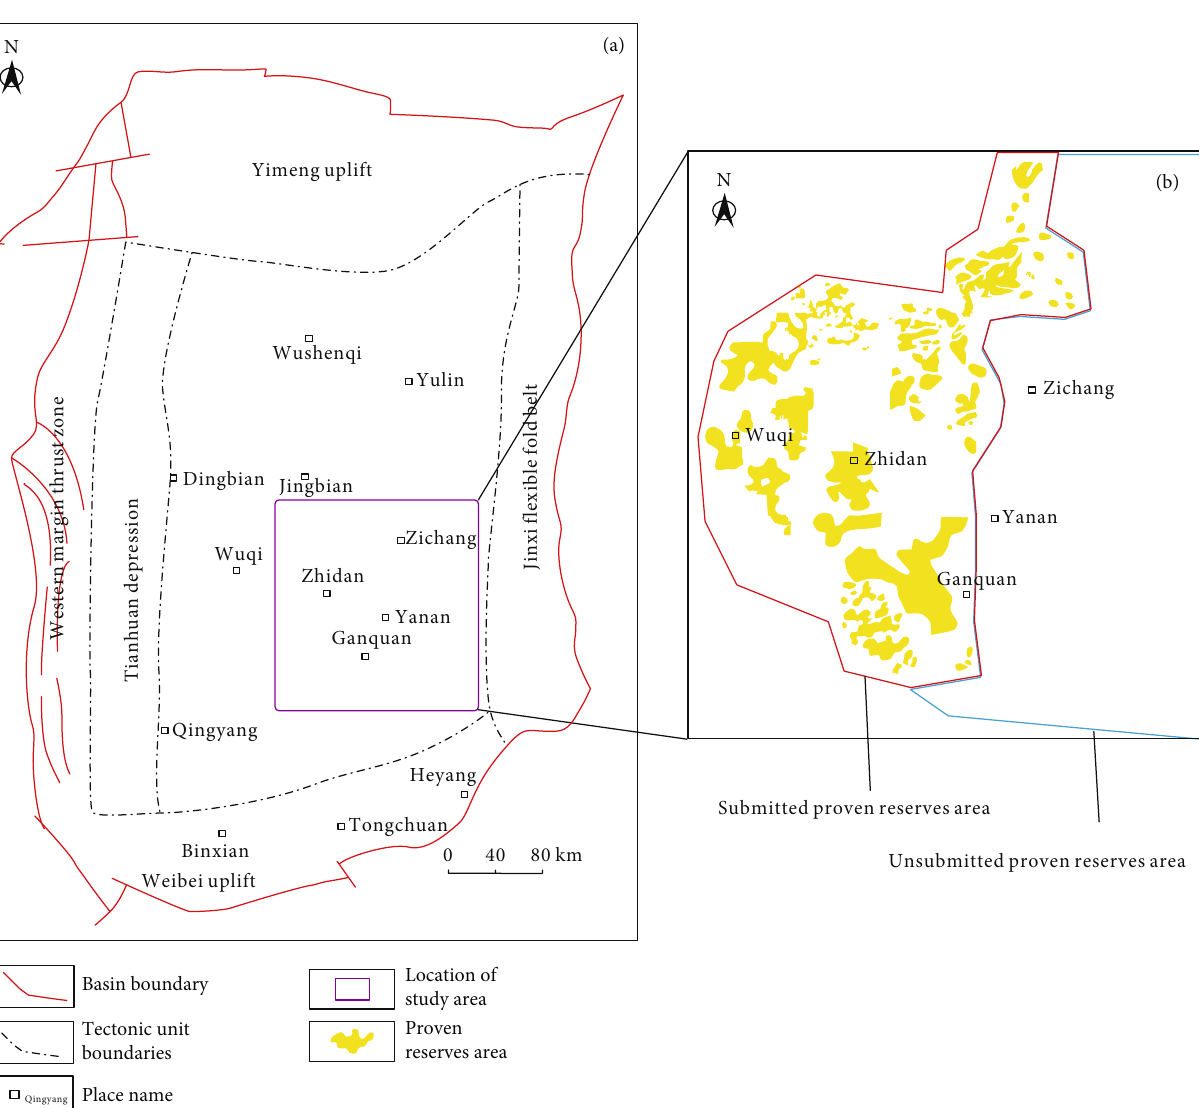
Figure 1: (a) Location of area in the Ordos Basin. (b) Reserve distribution area of the Yan ’ an gas fi eld, yellow square shows the submitted proven reserves